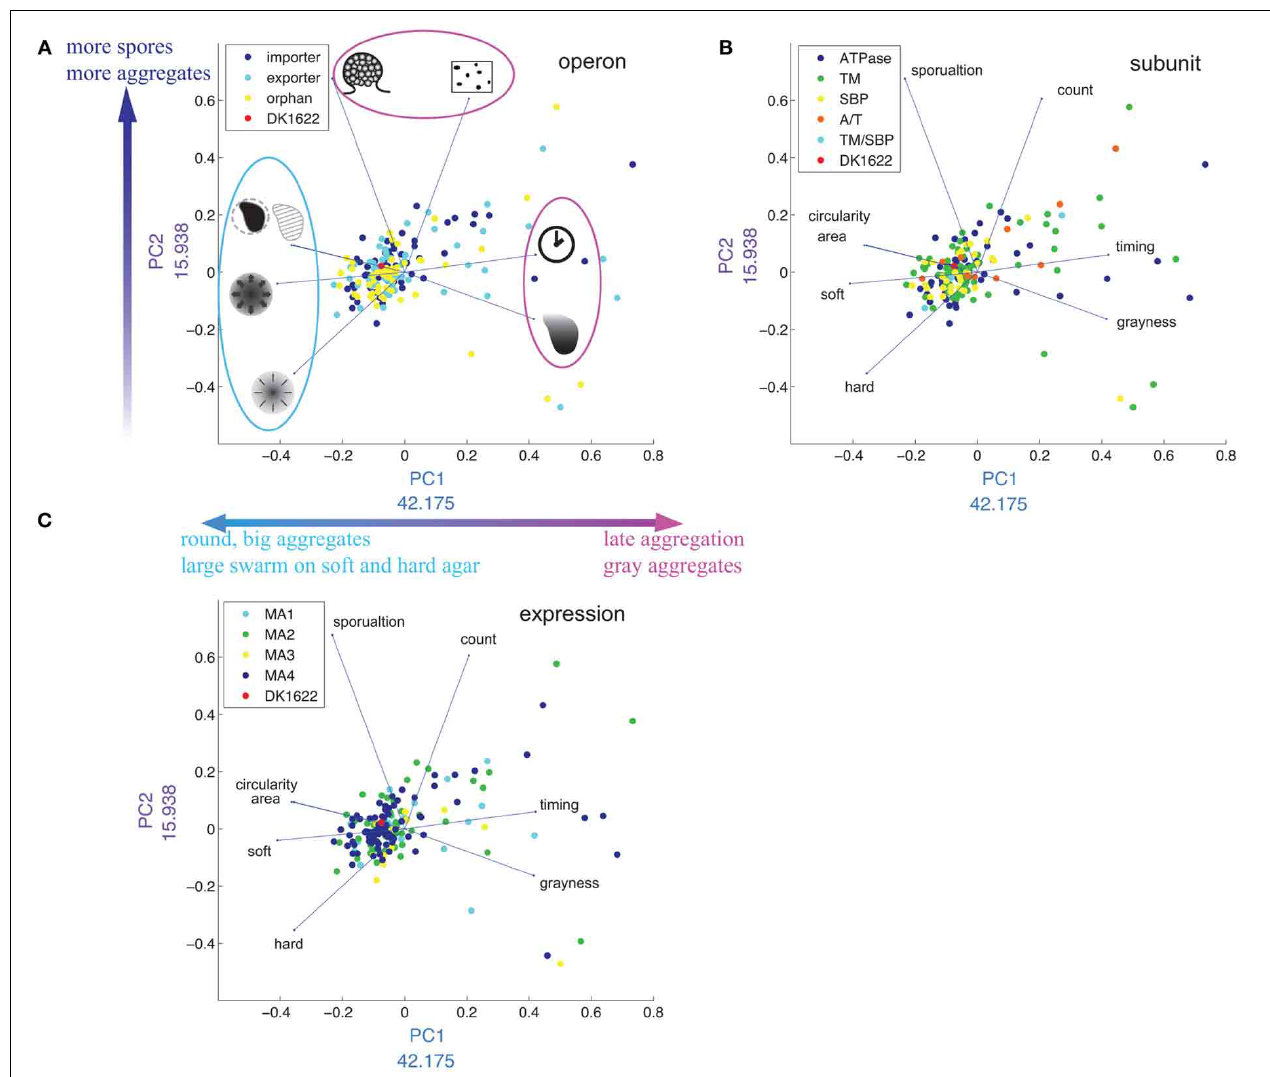
FIGURE 8 | Distribution of phenotypes in multidimensional scaling using PCA. (A–C) Are the same plot of PC1 against PC2, except that the plots are color coded by operon (A) , subunit (B) , and expression cluster (C) . In (A) ,